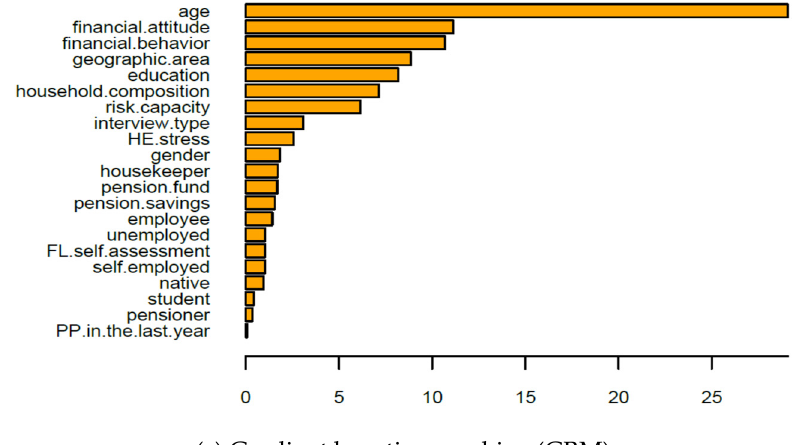
Figure 4. Variable importance with ML models.